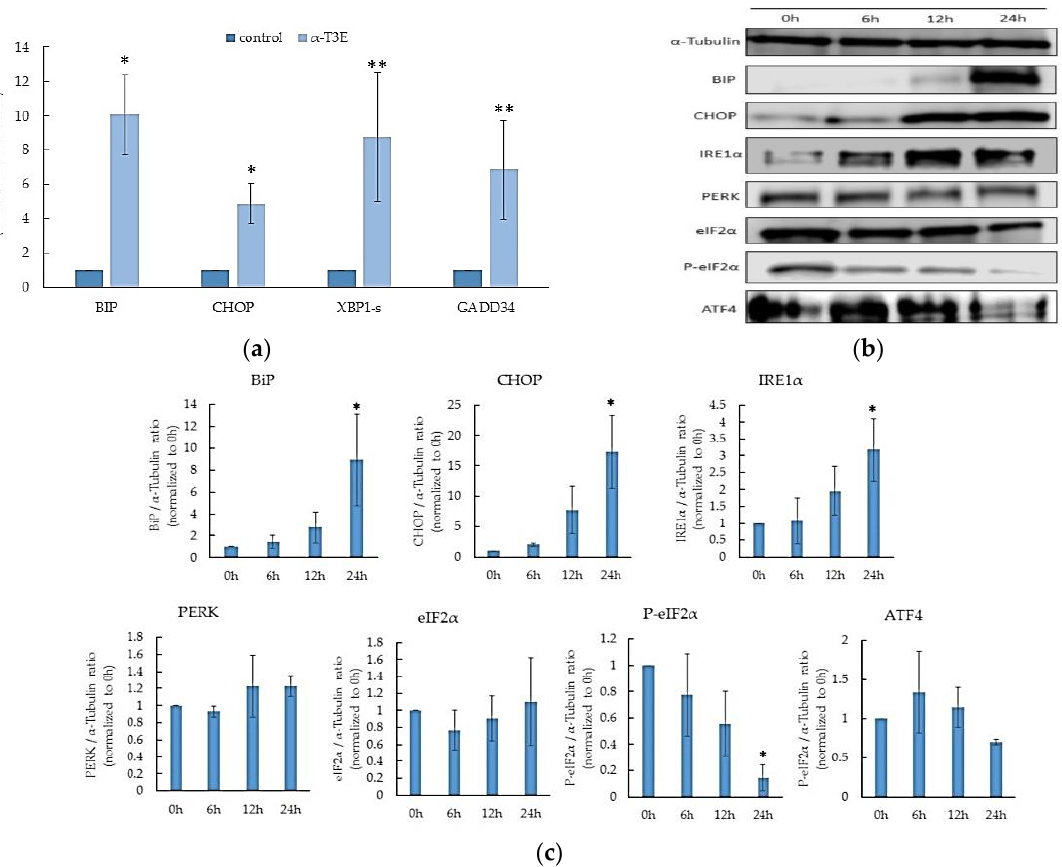
Figure 5. Inducing effects of α -T3E on ER stress in H2452 cells. ( a ) Cells were treated with α -T3E (20 µM) for 24 h, and the mRNA levels of ER-stress-related molecules were assessed by real-time quantitative PCR. The data are means ± SD, n = 3. * p < 0.05, ** p < 0.01 vs. the control. ( b ) Cells were treated with α -T3E (20 µM) for the indicated periods, and the levels of ER-stress-related proteins were measured by immunoblotting. The α -Tubulin protein levels served as the loading control. ( c ) A densitometric analysis of ER-stress-related proteins was performed. The data are means ± SD, n = 3. * p < 0.05 vs. the control.